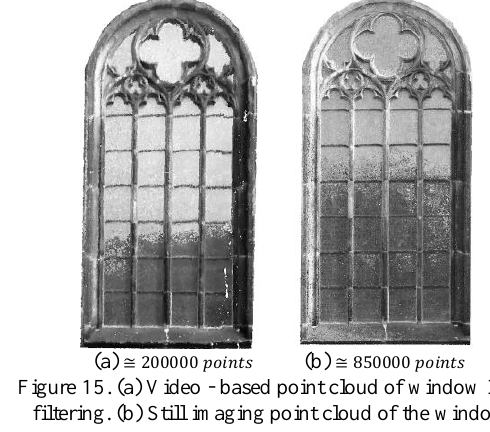
filtering. (b) Still imaging point cloud of the window I.